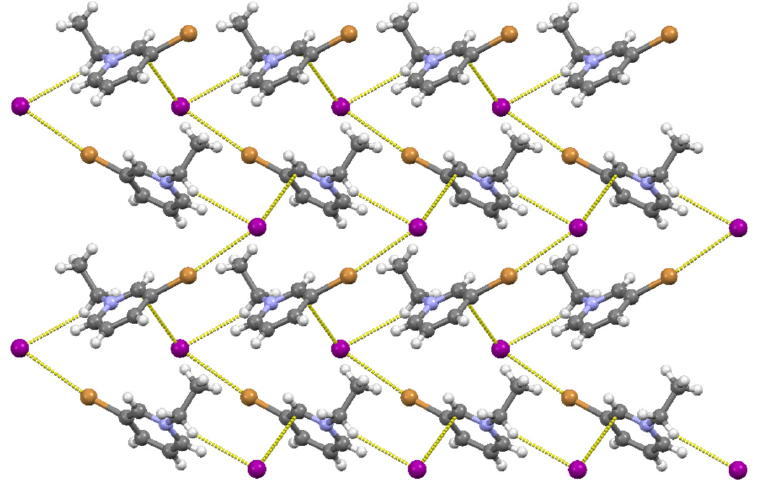
Figure 2. [ N -Et- 3-BrPy ] + cations and iodide anions connected into layers through C − Br · · · I − halogen bonds, C − H · · · I − hydrogen bonds and anion- π contacts in the structure of [ N -Et- 3-BrPy